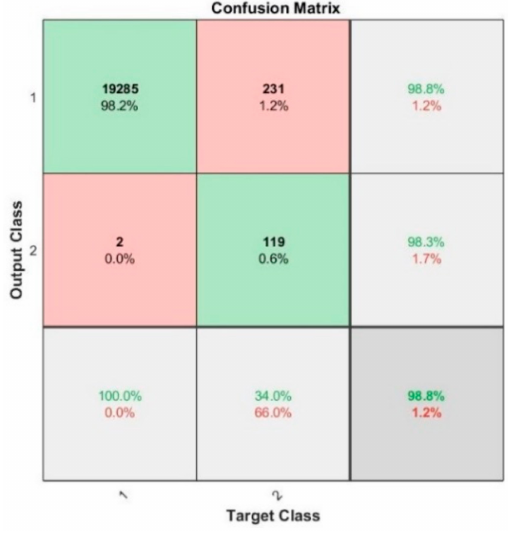
Figure 20. Confusion matrix.